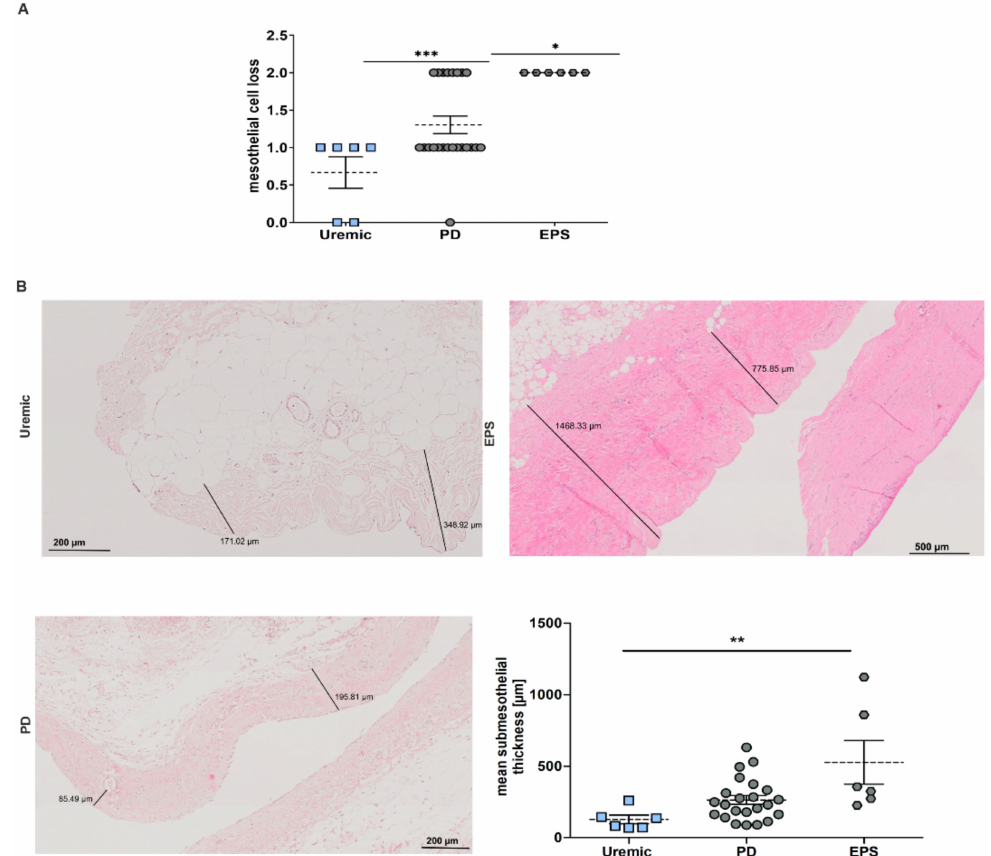
Figure 2. Pathological changes in the peritoneal membrane of PD patients. ( A ) Scatter blot of mesothelial cell loss of peritoneal biopsies (mean ± S.E.M.; *: p < 0.05, ***: p < 0.001; n = 6 except for PD: n = 23). ( B ) Representative HE sections of biopsy sections. Scatter blot shows the mean submesothelial thickness (mean ± S.E.M.; **: p < 0.01; n = 6 except for PD: n =